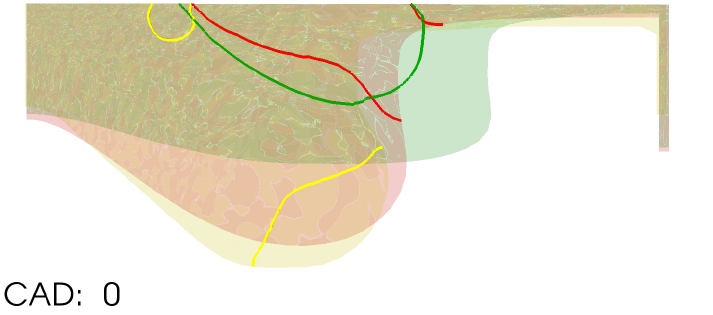
Figure 17. Fuel distribution in the different combustion chamber configurations—contour lines represent the area where the mixture is enriched by the direct injection. CAD:0 corresponds to Top Dead Center.